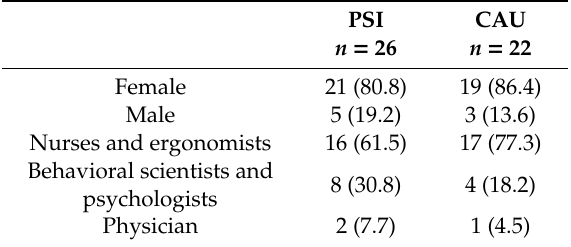
Table 2. Profession and Gender for the OHS Consultants in n